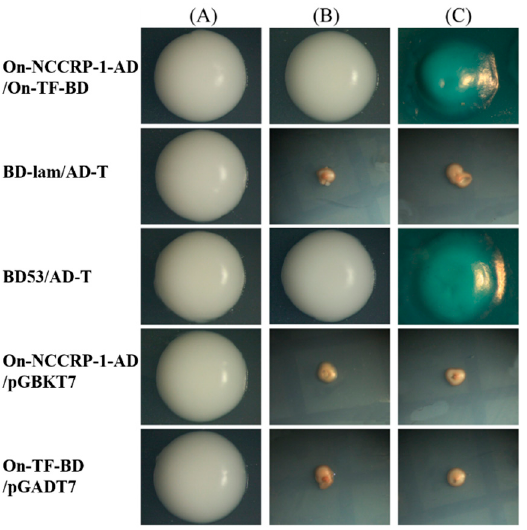
Figure 4. Y2H assay of the interaction between On-NCCRP-1 and On-TF. pGBKT7-On-TF/pGADT7-On-NCCRP-1 is the experimental group; pGBKT7-Lam/pGADT7-T is the negative control; pGBKT7-53/pGADT7-T is the positive control; pGADT7-On-NCCRP-1/pGADT7 and pGBKT7-On-TF/pGBKT7 are the self-activation groups. Column ( A ): Yeasts grown on plates with double dropout medium (SD/–Leu/–Trp). Column ( B ): Yeasts grown on plates with quadruple dropout medium (SD/-Leu/-Trp/-His/-Ade). Column ( C ): Yeasts grown on plates with quadruple dropout medium supplemented with X-a-Gal (SD/-Leu/-Trp/-His/-Ade/X-a-Gal).